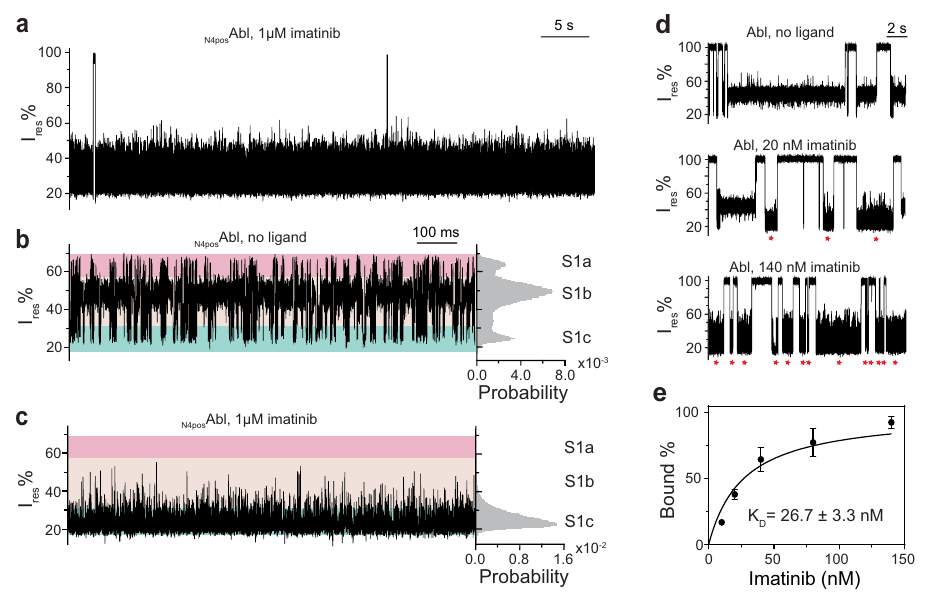
Fig. 4 Interaction of imatinib with Abl kinase. a A representative trace of N4pos Abl trapped within ClyA-AS nanopore tweezers in the presence of 1 µ M imatinib. b , c Representative zoomed-in traces and corresponding histograms of apo N4pos Abl ( b ) and imatinib-bound N4pos Abl ( c ) observed with ClyA-AS nanopore tweezers. S1 sub-states S1a, S1b and S1c were highlighted with pink, beige and cyan, respectively. The current traces were collected at − 80 mV in the buffer 150 mM NaCl, 100 mM Tris-HCl, pH 7.5, at 22 °C, with ~100 nM N4pos Abl added to cis chamber. d Representative traces of Abl titrated with different concentrations of imatinib (0, 20 nM, 140 nM). Red star indicates imatinib-bound Abl events. The current traces were collected at − 90 mV in the buffer 150 mM NaCl, 100 mM Tris-HCl, pH 7.5, at 22 °C, with ~100 nM Abl and different amount of imatinib added to cis . e Determination of the apparent K D of imatinib by plotting the imatinib bound event population over imatinib concentration. Data were represented as mean ± SD, replicates. Source data are provided as a Source Data fi